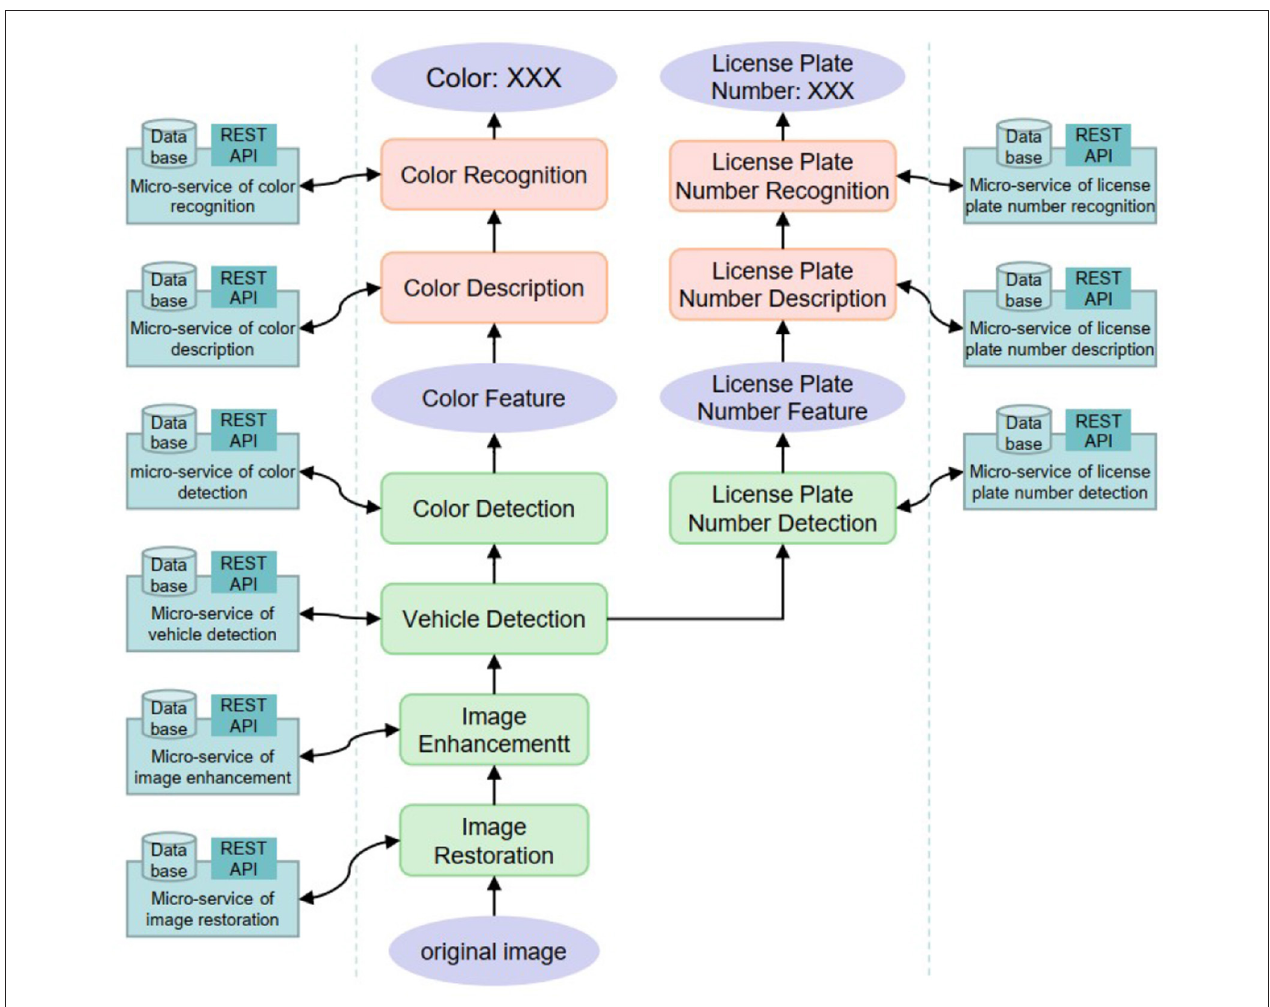
FIGURE 7 | Micro-services in image